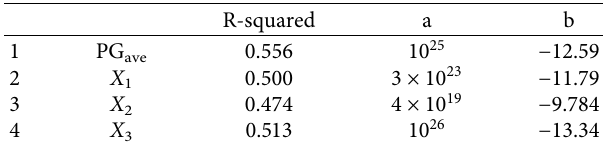
� 15). ave and rut depth ( n Figure 6: Correlation between X3 and rut depth ( n � Table 10: Nonlinear correlation between rut depth and inde- pendent variables.